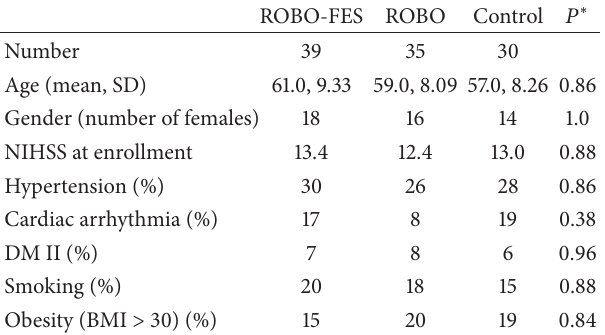
Table 1: Patient demographics and cardiovascular risk variables. ROBO-FES